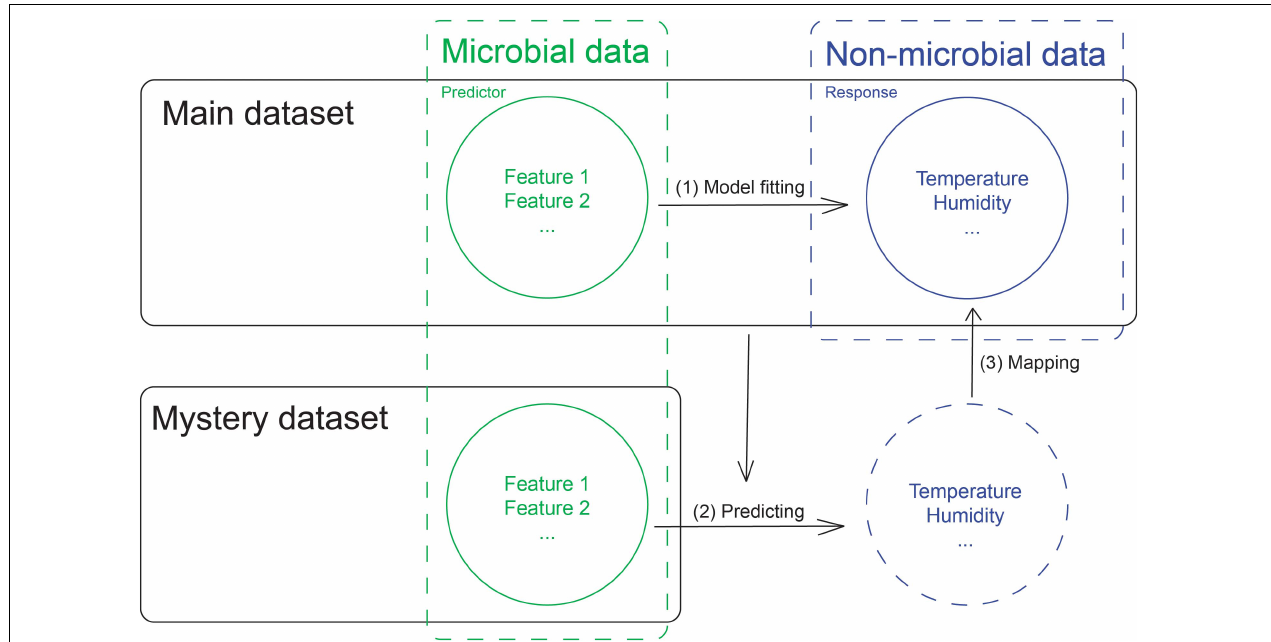
FIGURE 1 | The flowchart for the non-microbial feature prediction for the mystery samples.